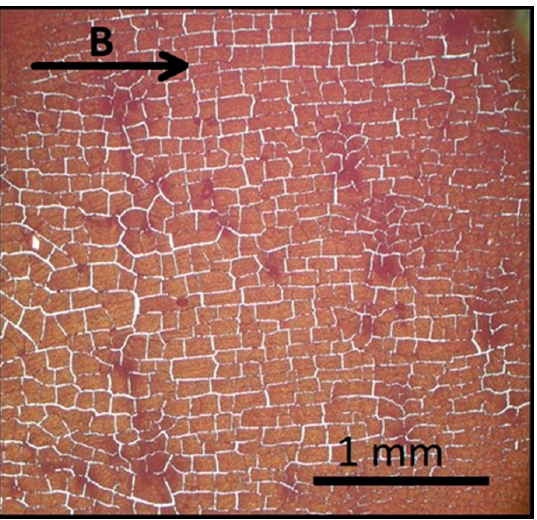
Figure 8. Formation of orthogonal blocks of 536 nm diameter MSNs arrays under an in-plane applied field deposited at φ = 10°. These blocks appear in densely covered areas of the substrate. The direction of applied field is indicated by the arrow.